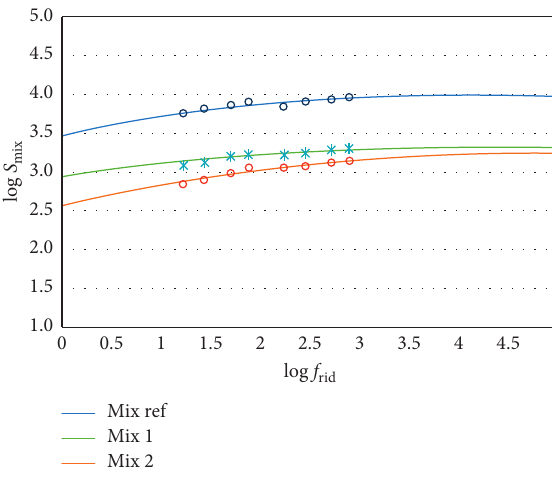
Figure 4: Stiffness modulus master curves.